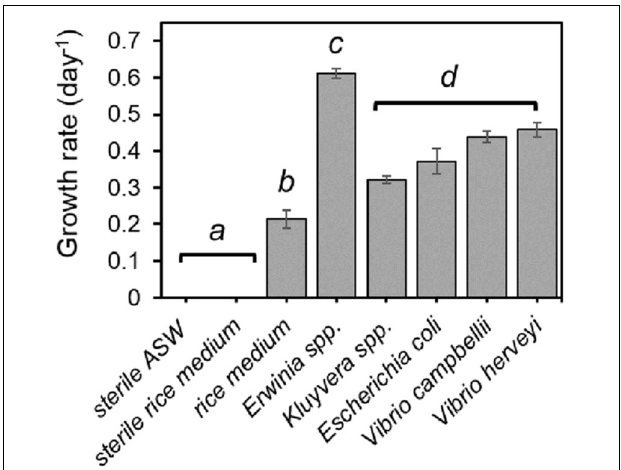
FIGURE 1 | The specific growth rate of Strombidium sp. NTOU1 fed with different bacteria. The error bar represents the standard deviation (SD) of the average from three independent experiments. The statistical significance of the growth rate between each group was analyzed by the ANOVA. Different letters (a, b, c, and d) indicate a significant difference ( p < 0.05) between different